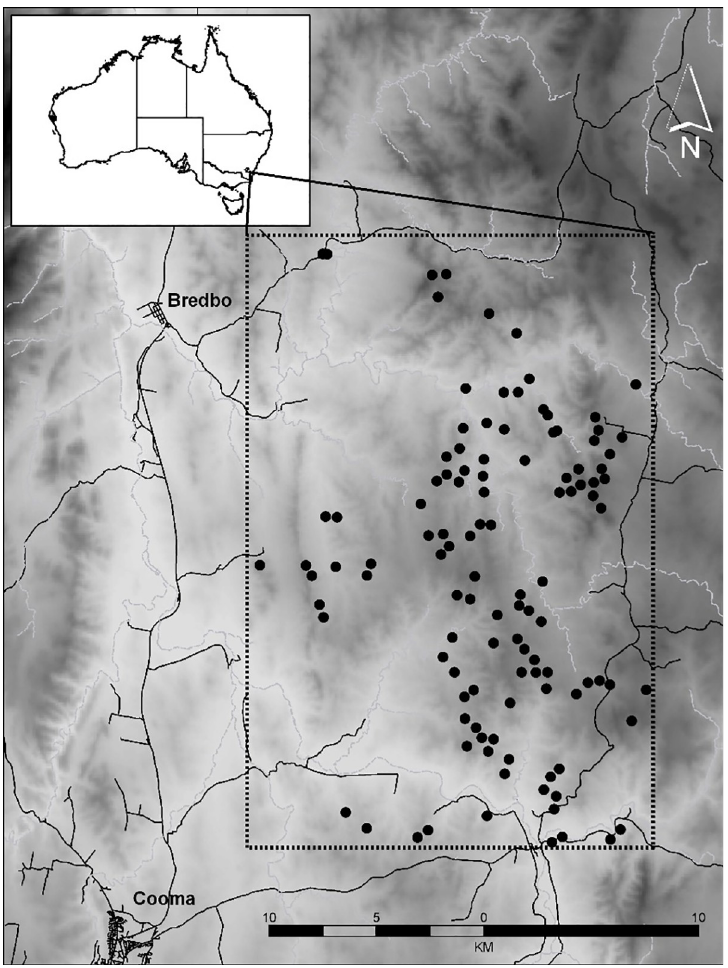
Fig 1. Map showing the designated study area (black rectangle) and the 100 surveyed sites (black circles), with the towns of Bredbo and Cooma marked as reference points. Roads are represented by solid black lines and waterways by thin grey lines. Elevation is represented on a shading scale from white (750 m) to dark grey (1250